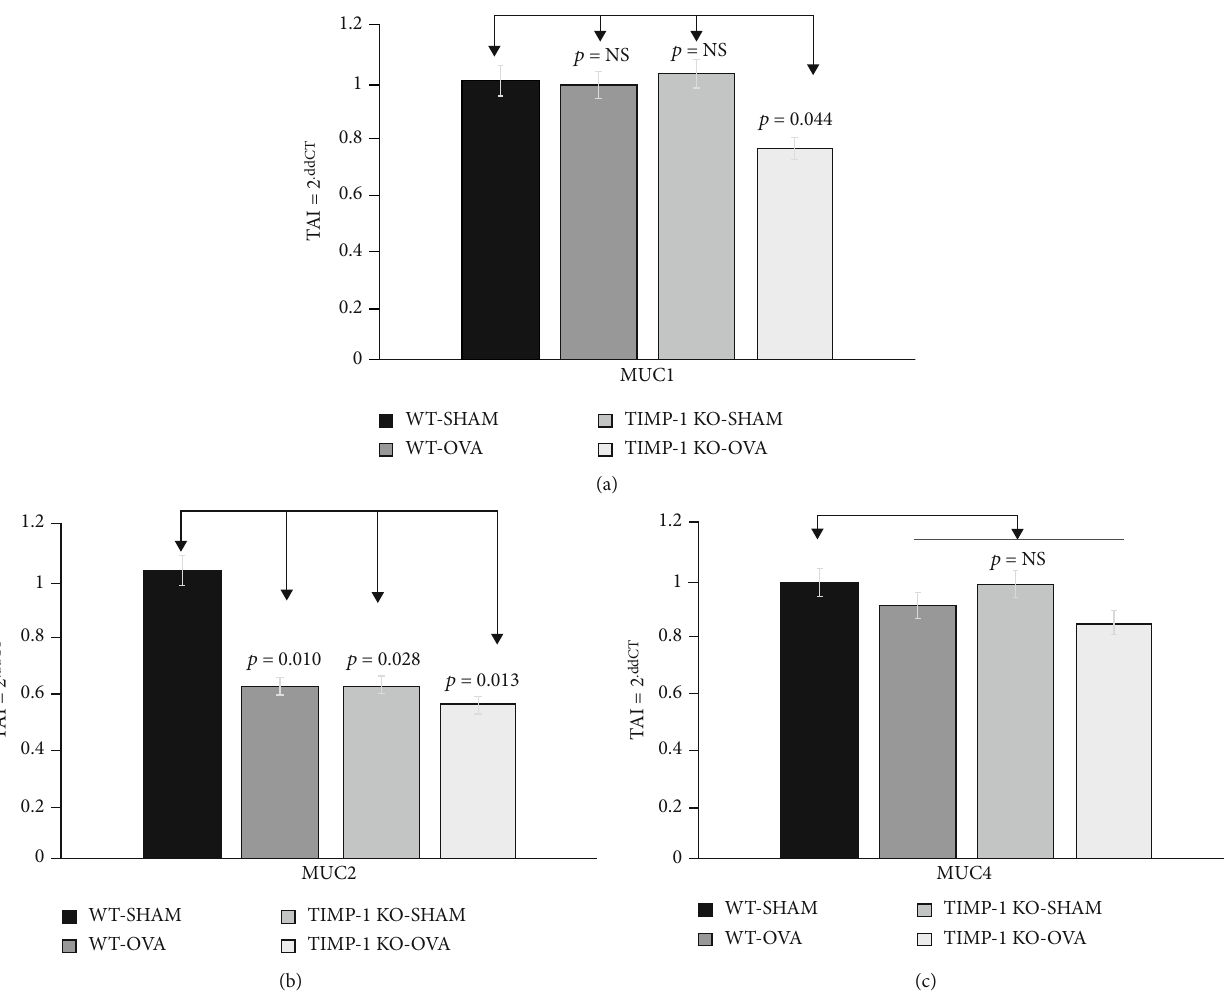
Figure 4: Membrane-bound mucins MUC1, MUC2, and MUC4 gene expression in lung tissue obtained from OVA-sensitized TIMPKO, OVA-sensitized TIMPKO, OVA-sensitized WT, and WT-SHAM mice. Comparative real-time qPCR analysis showing the relative gene expression of MUC1, MUC2, and MUC4 in lung tissue obtained from OVA-sensitized TIMPKO, OVA-sensitized TIMPKO, OVA- sensitized WT, and WT-SHAM mice. Data normalized to the housekeeping gene β -actin and with WT-SHAM as control. Gene expression was calculated using the comparative CT method. Results are expressed as the mean ± SD , n = 3 separate